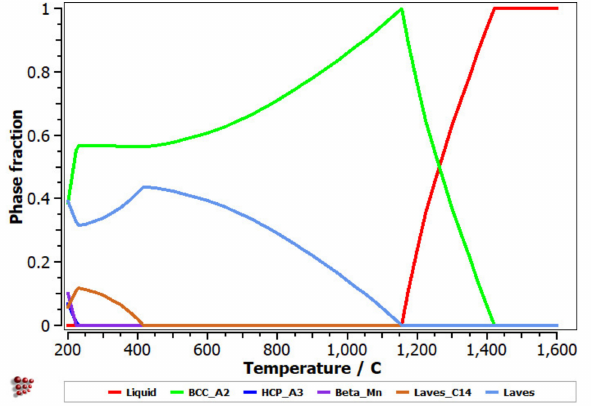
Figure 7. Equilibrium diagram of the FeMnNb 0.5 TiZr 0.5 alloy. The Scheill–Gulliver solidification curve (Figure 8) indicates a high degree of subcool- ing. The model of the solidification process of the alloy and considering Zr diffusion and its impact on changing the structure in the solidification area, a decrease in the subcooling degree can be observed.